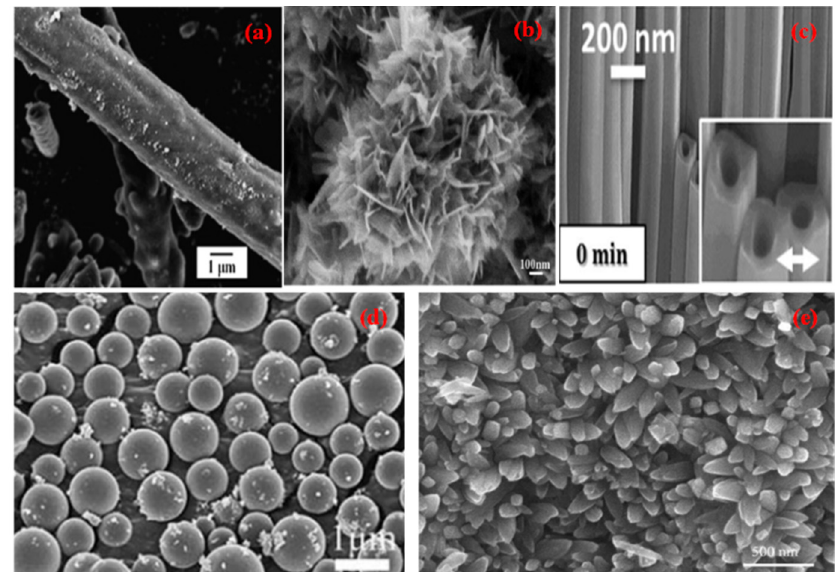
Figure 1. SEM micrographs of different nano morphologies of TiO 2 ( a ) Nanorod (Reprinted with